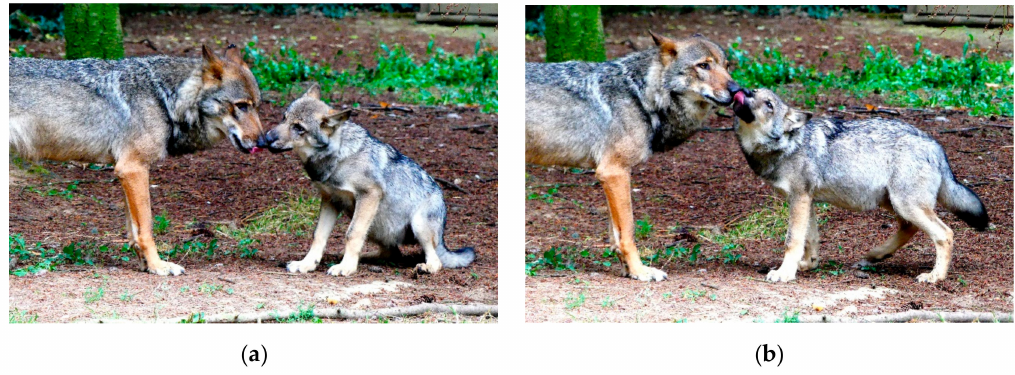
Figure 1. Reciprocal muzzle licking during a post-conflict triadic a ffi liation (“consolation”) between an adult (the consoler) ( a ) and an immature subject (the victim) ( b ) Photos by Elisabetta